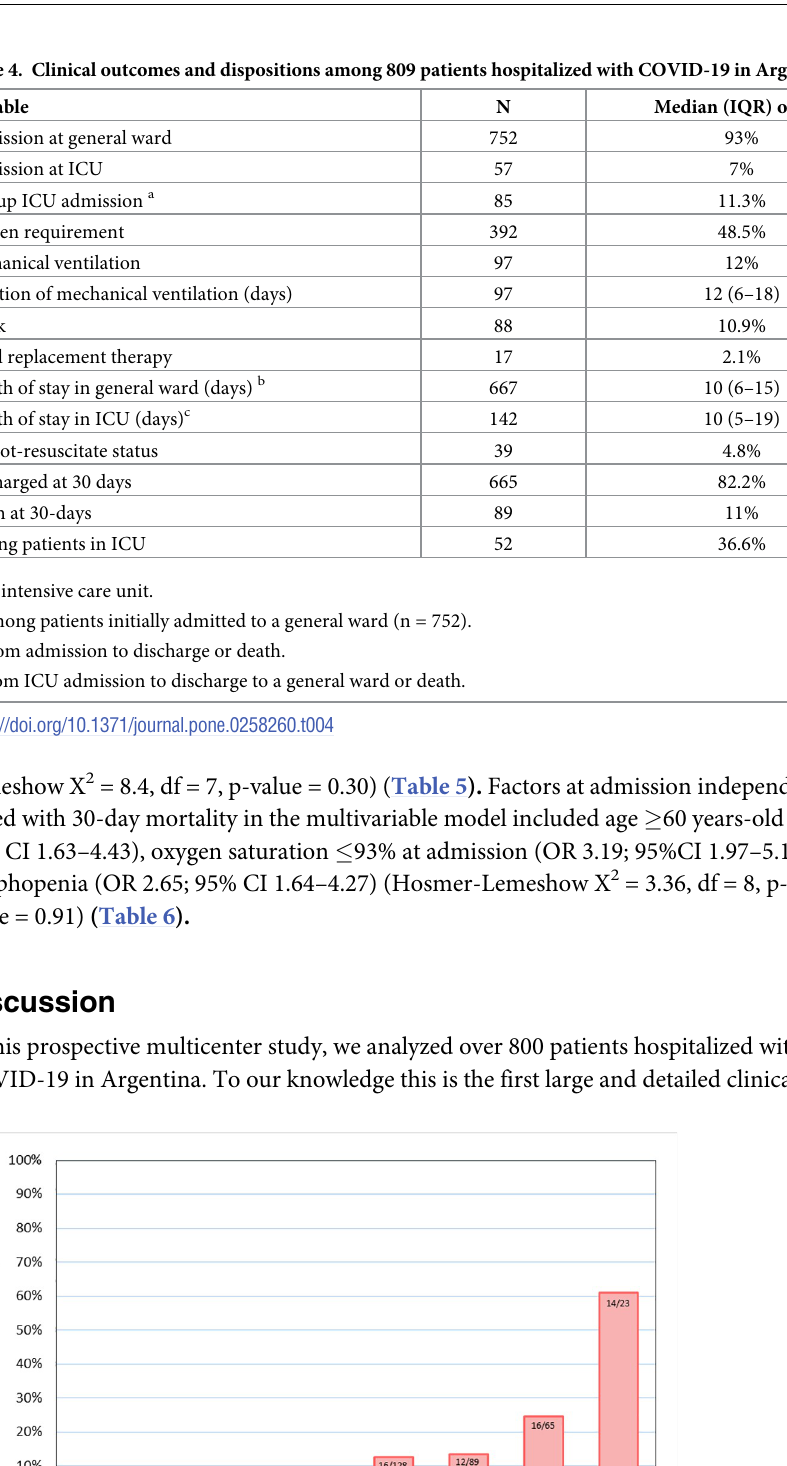
Table 4. Clinical outcomes and dispositions among 809 patients hospitalized with COVID-19 in Argentina. Variable